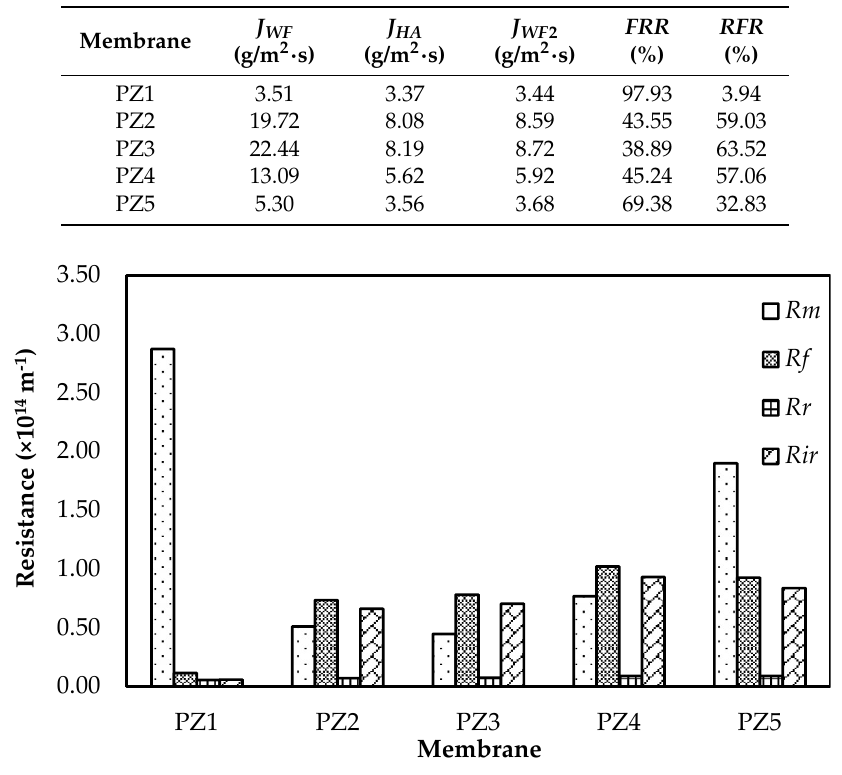
Figure 4. The membrane resistance R m , R f , R r and R ir of PZ1 to PZ5.